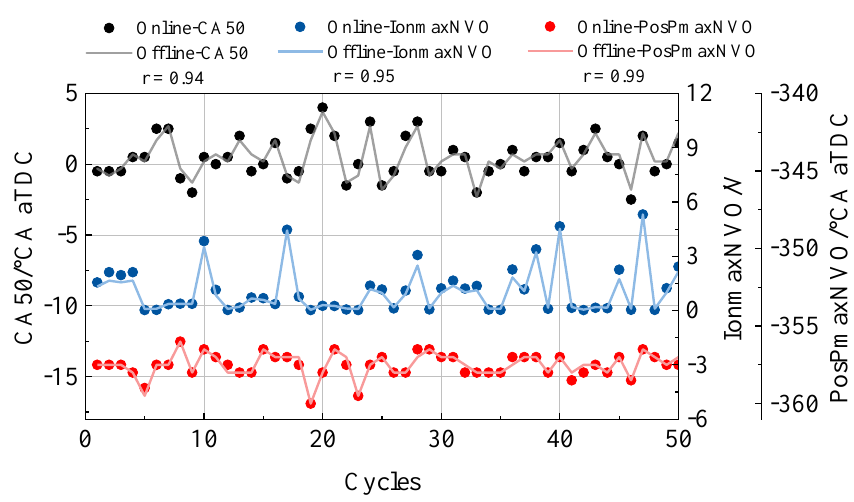
Figure 7. Comparison between online calculation results and offline calculation results.